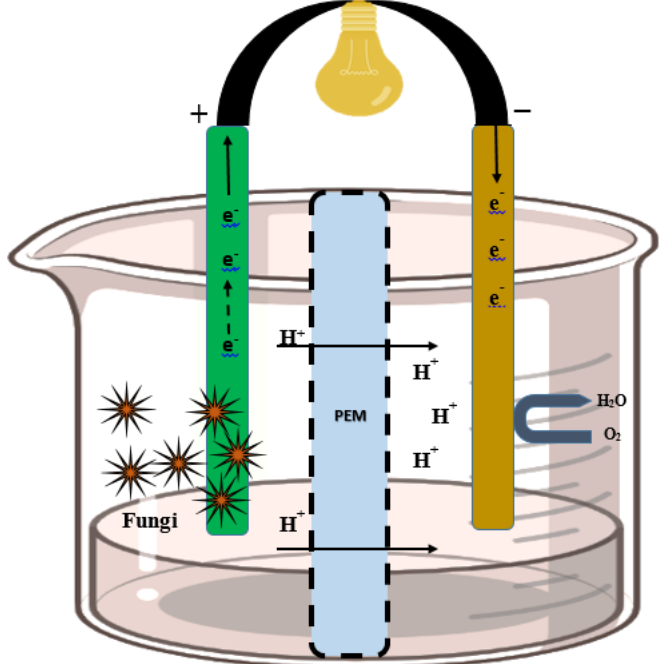
Figure 2. Structure of the fungal fuel cell. The left side of the cell is the fungal catalyst electrode (anodic chamber), and protons are transferred from the proton exchange membrane to the cathodic chamber (where catalytic oxidation takes place).